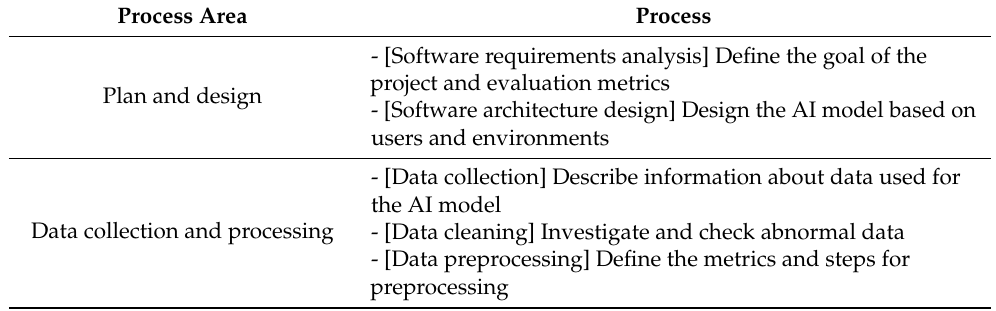
Table 2. Processes in common process